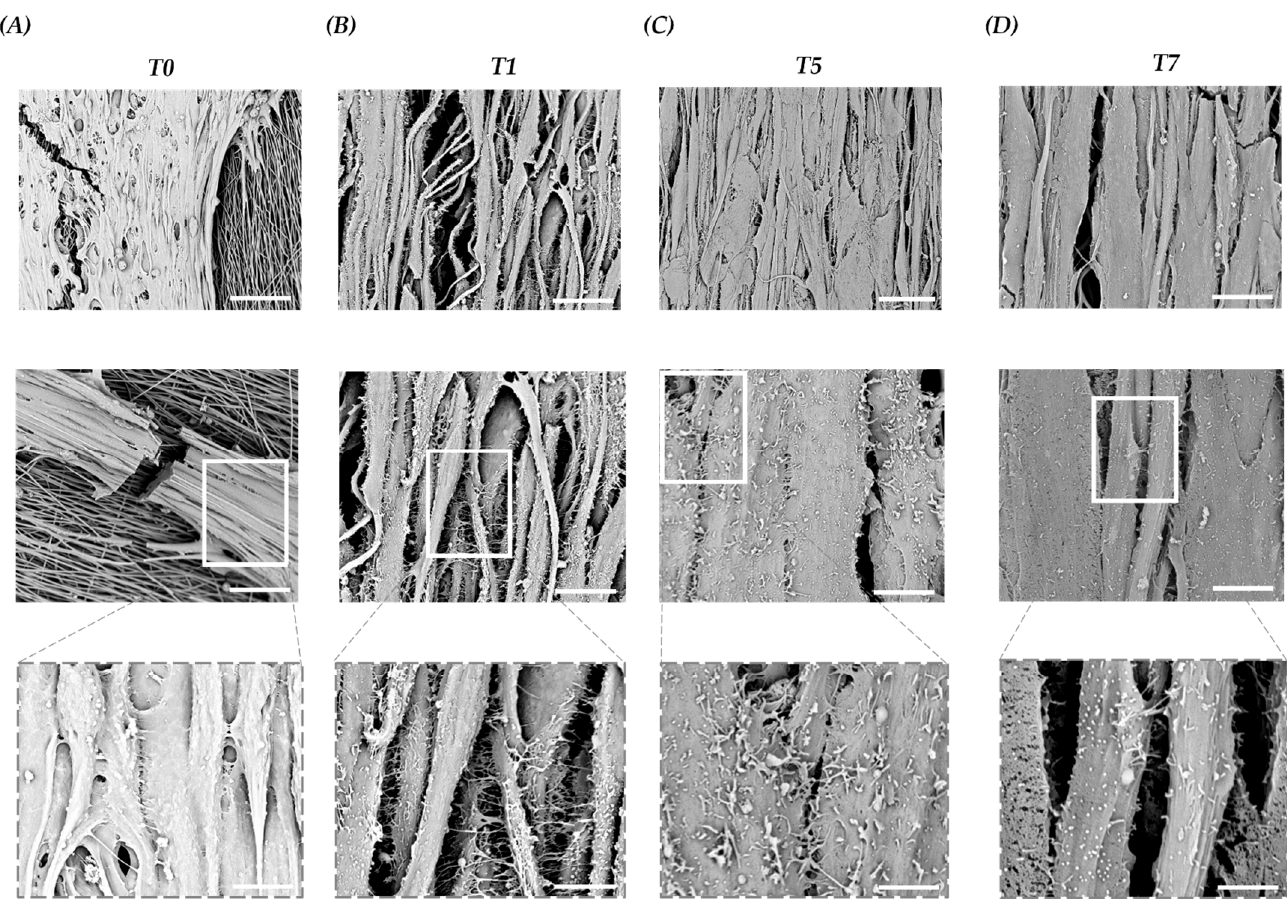
Figure 5. Representative SEM images of C2C12 on a scaffold at T0 and during differentiation (T1–T7). ( A ) At T0, aligned C2C12 myoblasts focus on cell–cell interactions and membrane structures. Scale bars: 50 μ m, 15 μ m and 5 μ m. ( B ) At T1, C2C12 myocyte interactions and development of cell–cell adhesions with increased membrane structures. Scale bars: 15 μ m, 5 μ m and 2.5 μ m. ( C ) At T5, myocyte fusion and myotube formation with lower membrane structures. Scale bars: 15 μ m, 5 μ m and 1.5 μ m. ( D ) At T7, enlarged size of myotubes with reduced membrane structures. Scale bars: 10 μ m, 5 μ m and 1.5 μ m.